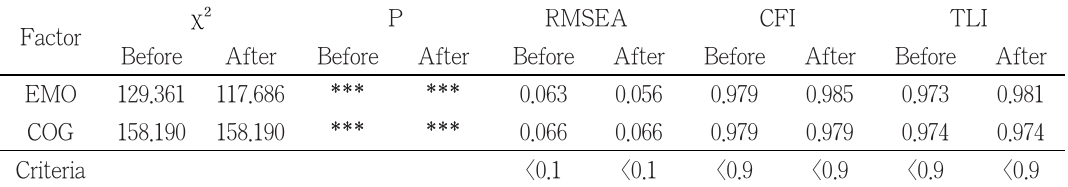
Figure 8. and Table 3. depict results of the path model. In Figure 8., upper models are before personalization models and lower models are after personalization models.